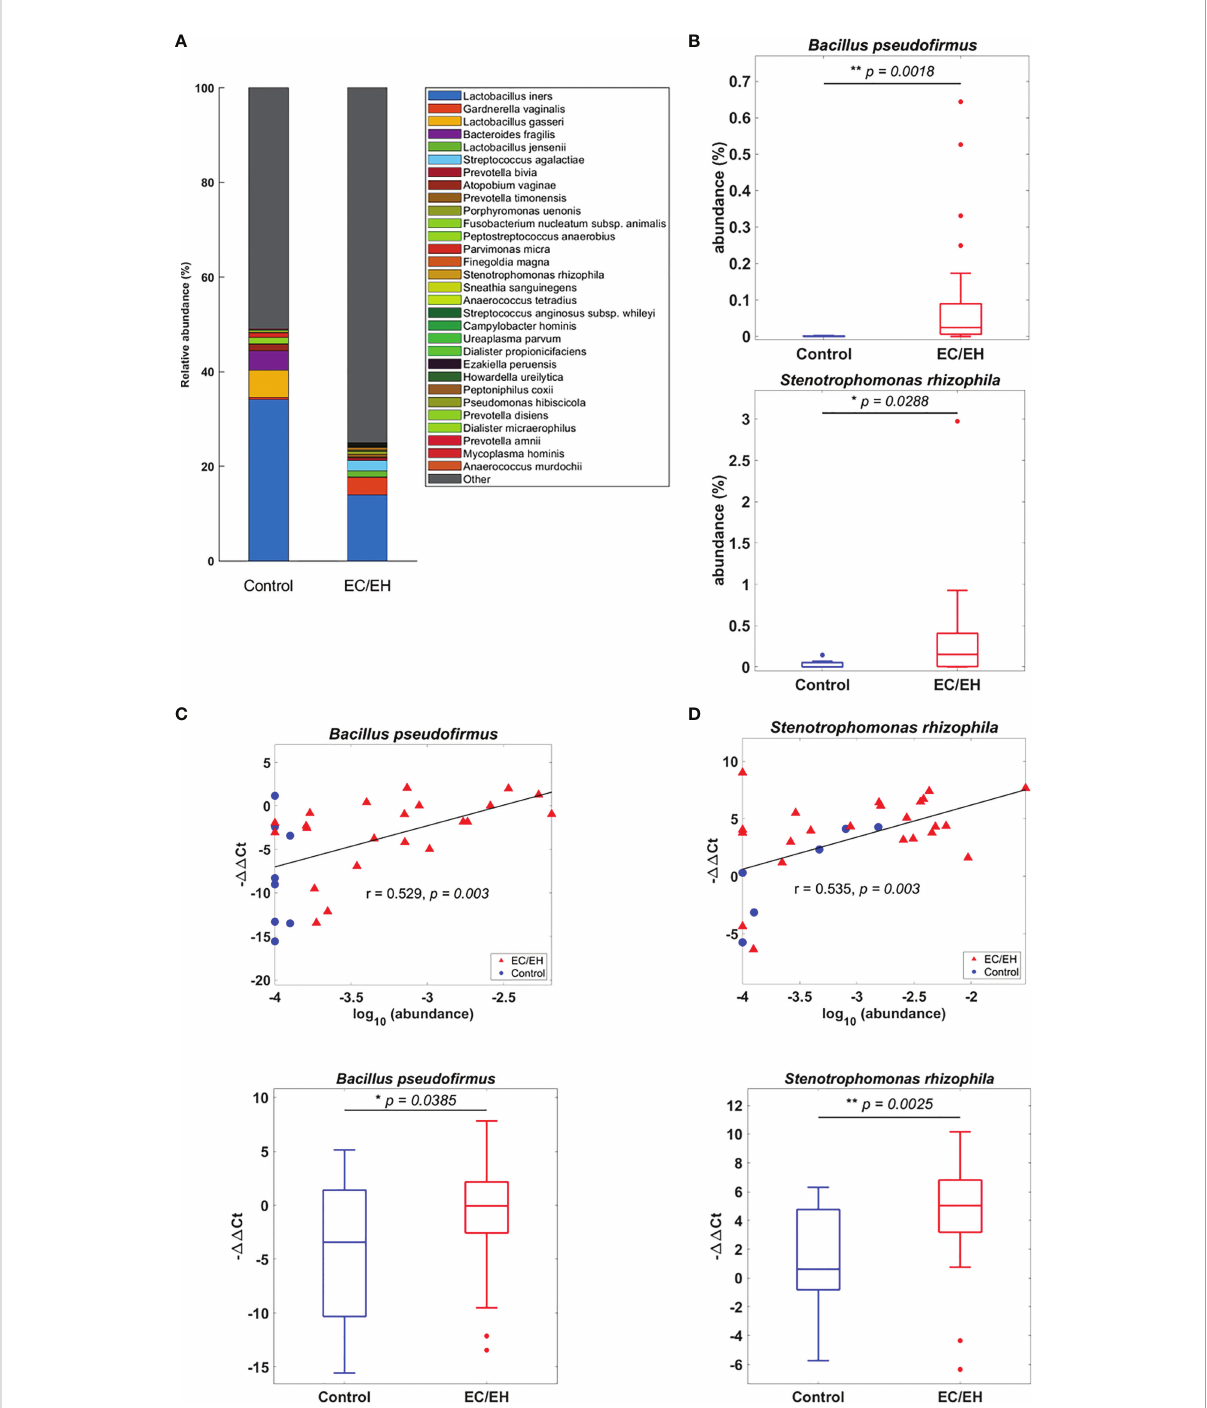
FIGURE 4 (A) Relative abundance of endometrial lavage bacteria in patients with EC/EH versus control women: taxonomic identi fi cation at the species level. (B) Box plots revealed statistically signi fi cant intergroup differences in the relative abundance of the species Bacillus pseudo fi rmus and Stenotrophomonas rhizophila . (C) The higher relative abundance of Bacillus pseudo fi rmus in patients with EC/EH was con fi rmed by the positive correlation between the results of gene sequencing (r = 0.529, P = 0.003; upper panel) and those of real-time qPCR (EC/EH samples, n = 54, control, n = 13, lower panel). (D) The higher relative abundance of Stenotrophomonas rhizophila in patients with EC/EH was con fi rmed by the positive correlation between the results of gene sequencing (r = 0.535, P = 0.003) and those of real-time qPCR (lower panel). “ * “ means statistically signi fi cant P<0.05, “ ** ”